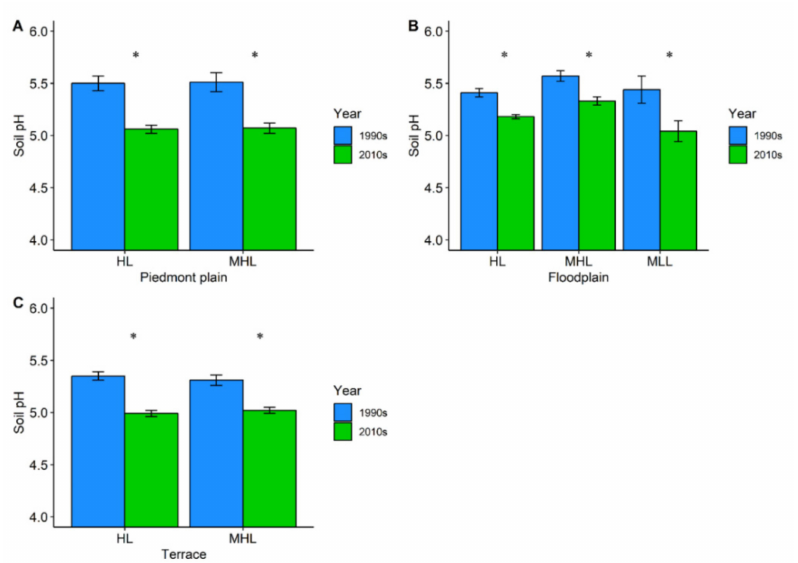
Figure 8. Soil pH (0–15 cm) across land types sampled in 1990s and 2010s in the ( A ) Piedmont plain, ( B ) Floodplain and ( C ) Terrace physiography. The error bars represent respective standard errors. The significant difference is indicated by ”*“